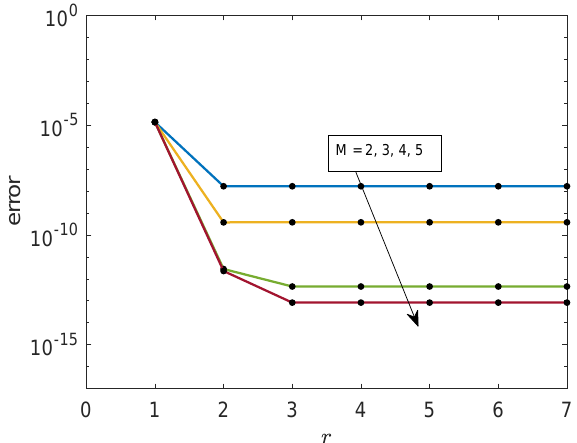
Figure 11. Errors for non-linear example 2.